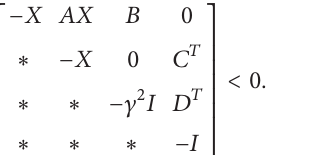
Figure 1: State trajectories of all